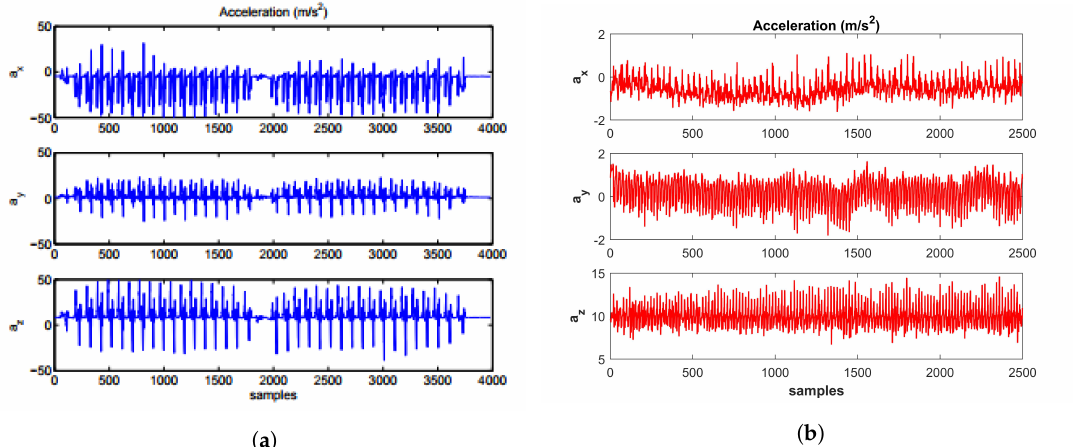
Figure 4. Acceleration data from the Inertial Measurement Unit (IMU), ( a ) foot mounted [53], ( b )